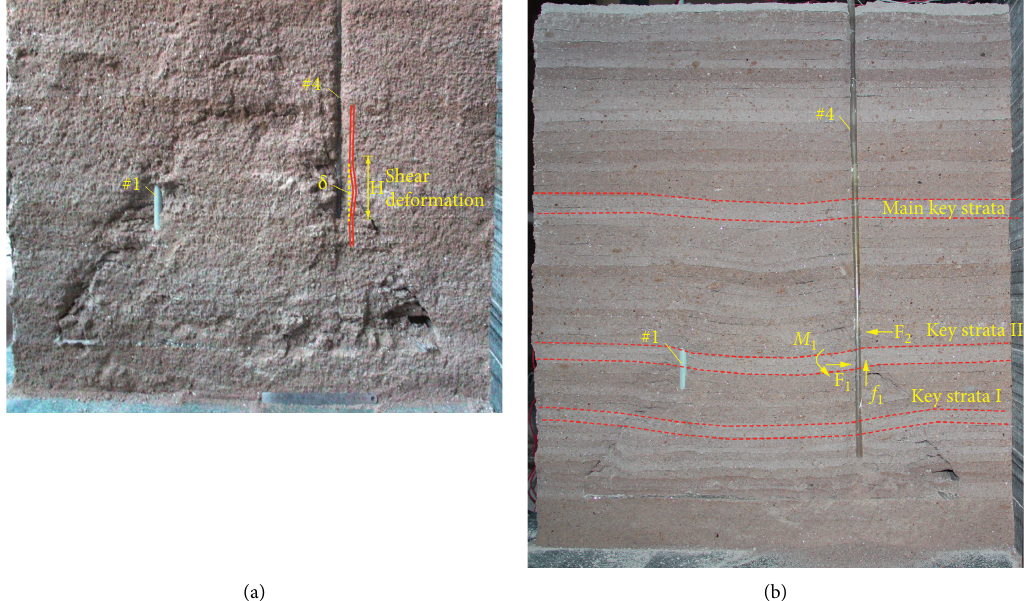
Figure 11: Measurement of the rubber pipe deformation in the surface well #4. (a) Localized S-shaped deformation. (b) Deformation of the surface well #4 due to mechanical